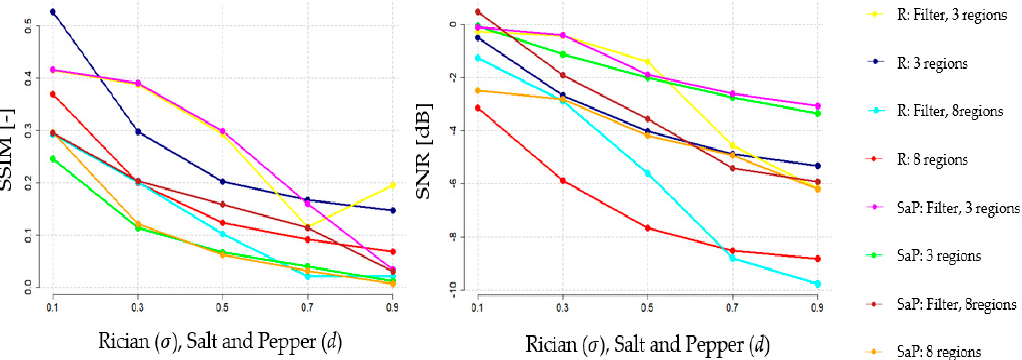
Figure 9. Segmentation based on Fuzzy thresholding performance (3 and 8 regions) with dynamical influence of noise Rician and Salt and Pepper based on SSIM and SNR analysis.